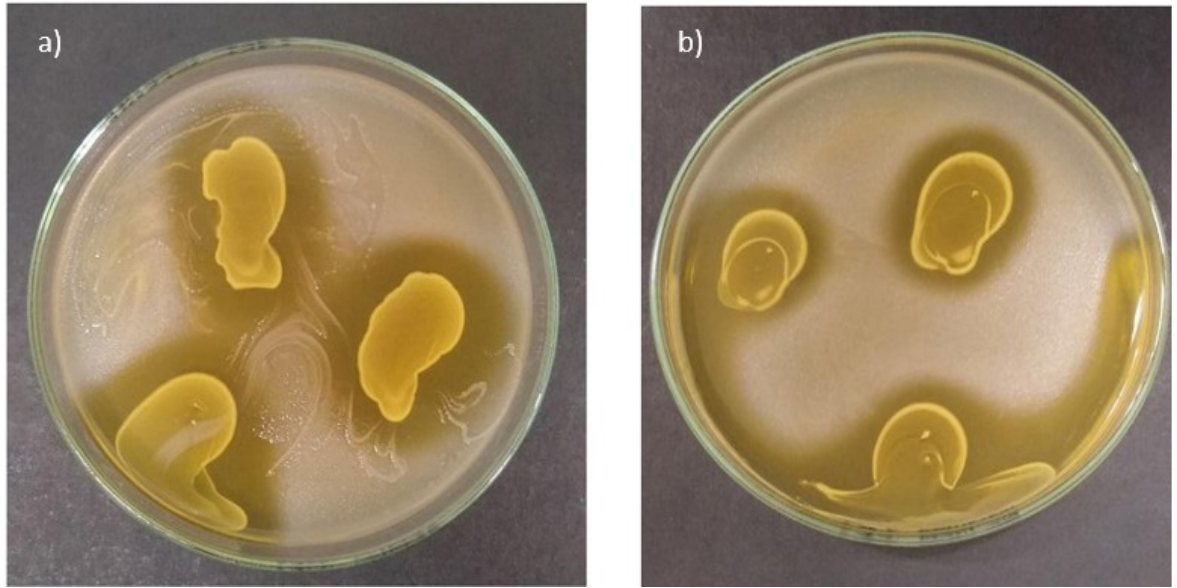
Figure 1. Antimicrobial activity of intact (a) and chloroform-inactivated (b) Lactiplantibacillus plantarum 6.2 against Gardnerella vaginalis demonstrated by the formation of a zone of inhibition at the inoculation points by the agar overlay antagonism evaluation